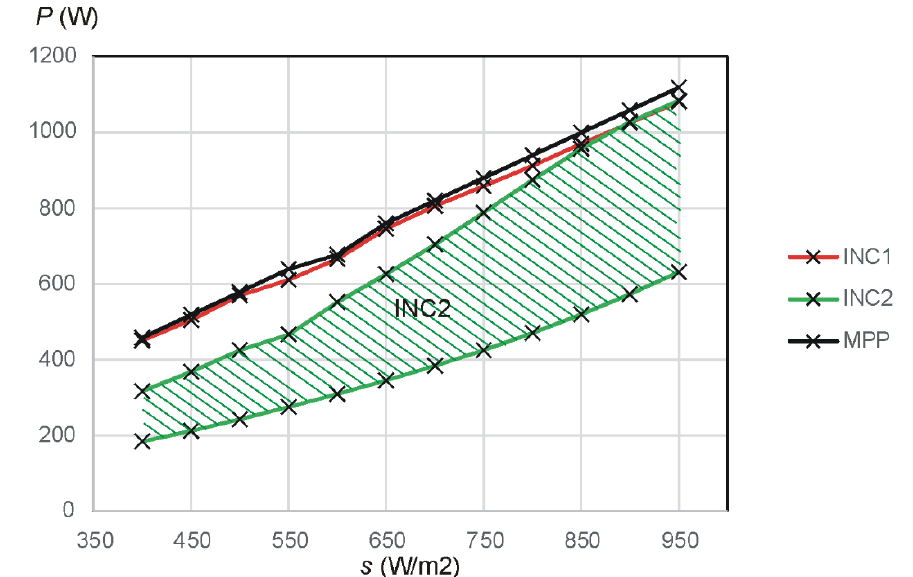
Figure 12. Measured power in W delivered to the grid with proposed MPPT (INC1); with the incremental conductance MPPT (INC2) as an area determined for di ff erent fixed increments and maximum power point (MPP) versus solar irradiances s in W / m 2